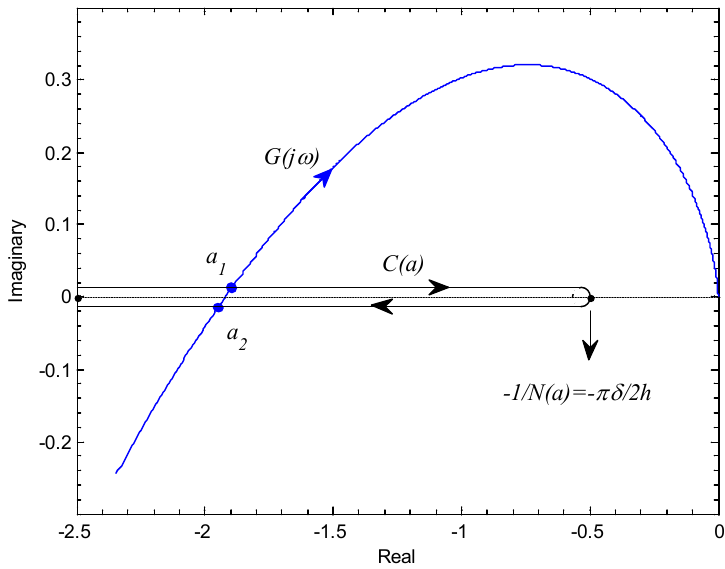
Figure 22. Nyquist plot of